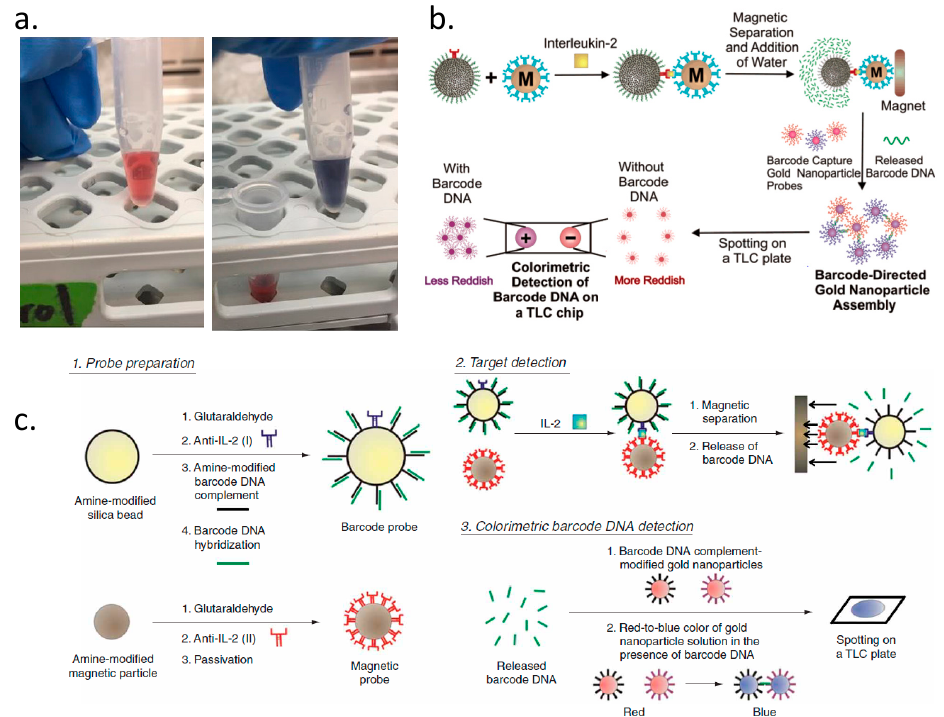
Figure 4. Non-fluorescent barcodes. The colorimetry detection is realized by DNA hybridization based gold nanoparticle aggregation. ( a ) The separated gold nanoparticle (red) are aggregated (blue) after DNA hybridization, reprinted with permission from Reference [26] Copyright (2017) biosensors. ( b ) The gold nanoparticle related colorimetry could achieve attomolar (aM) level sensitivity by combining DNA oligonucleotide with antibody and particles, reprinted with permission from Reference [27] Copyright (2005) American Chemical Society. ( c ) With similar technology, the gradient concentration of targets could be detected according to the color change of gold nanoparticle reagent, reprinted with permission from Reference [28] Copyright (2007) Springer Nature.